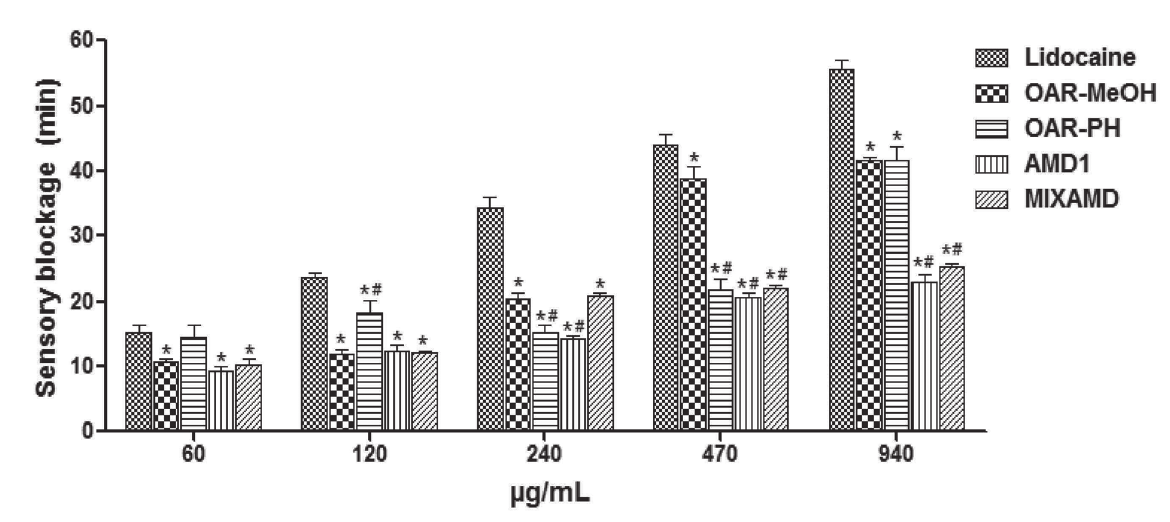
Figure 2 - Duration of anesthesia induced by intradermal administration in guinea pigs of lidocaine (n= 5), OAR-MeOH (n= 4), OAR-PH (n= 4) and amides AMD1 (n= 4) and MIXAMD (n= 4). The bar represents the mean ± SEM. * p <0.05 vs. lidocaine; # p <0.05 vs